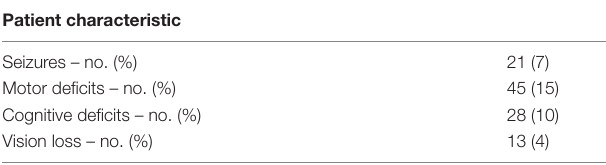
TaBle 2 | Baseline neurological examination and symptoms.